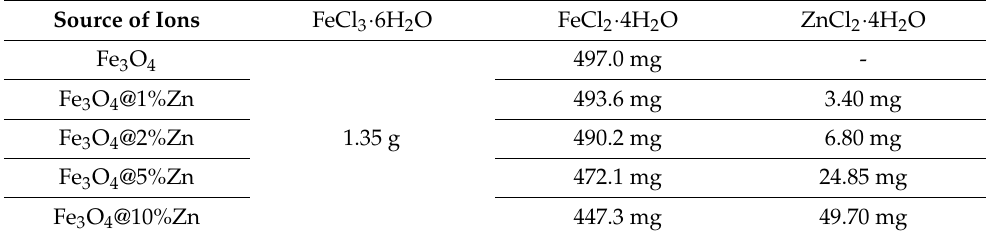
Table 1. Mass of particular salts used for synthesis of iron oxide-based